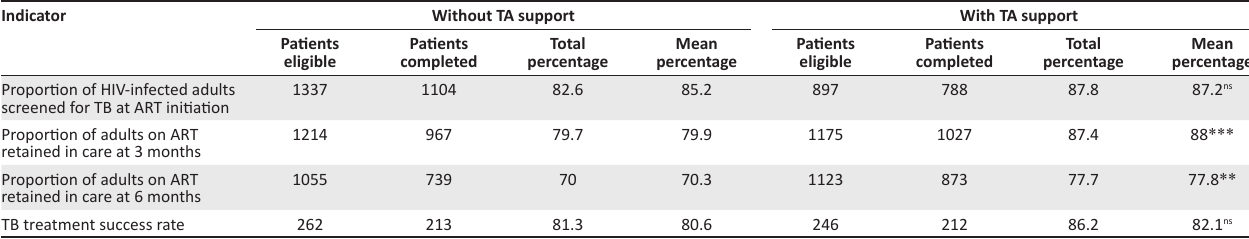
TABLE 5: Total and percentage change in indicators pre- and post-support.